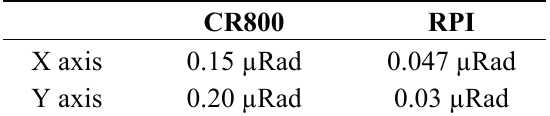
Table 15. Noise measured in both acquisition